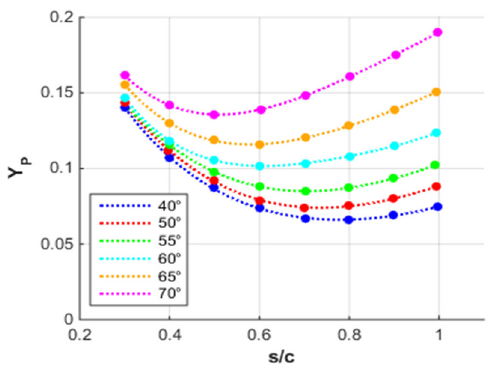
Figure 4. Cascade plots for profile loss where inlet angle=outlet angle.